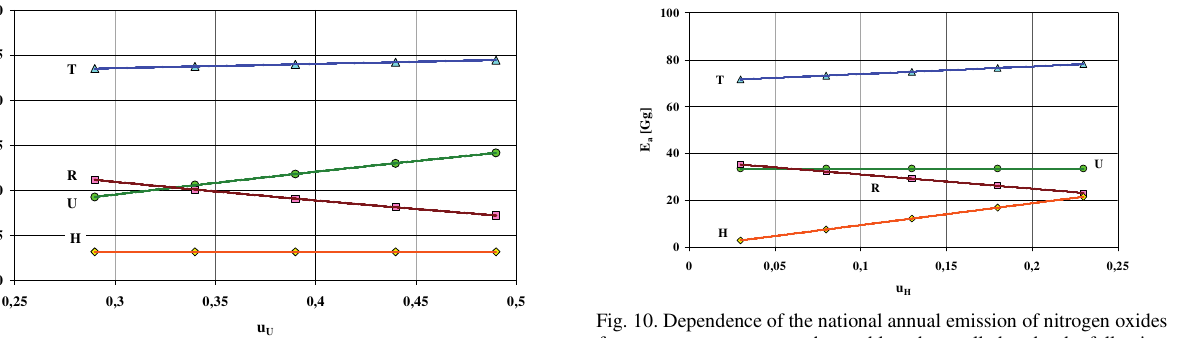
Fig. 7. Dependence of the national annual emission of carbon dioxide from passenger cars upon the road length travelled under the following model